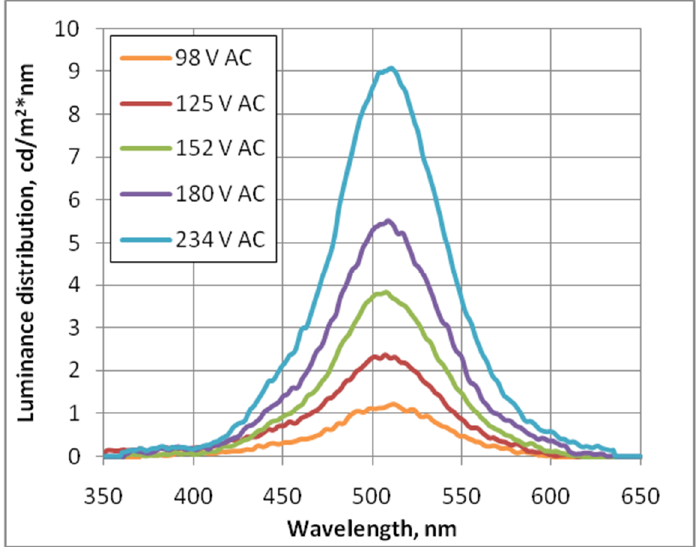
Figure 7. Luminance distribution for EL display with CNT based electrode supplied with different AC voltage with 1 kH frequency.